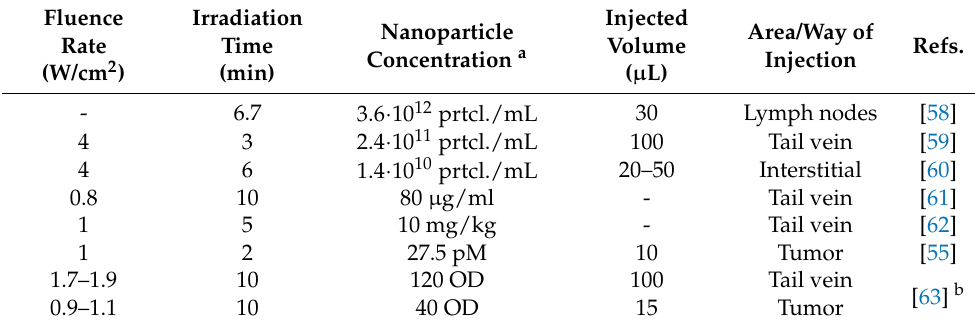
Table 4. Basic parameter values of in vivo PPTT in